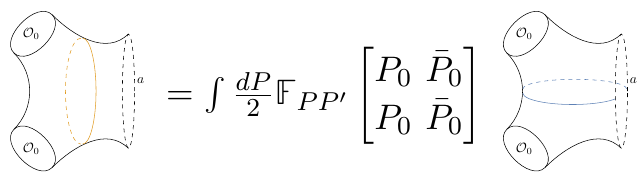
Figure 3 . The bulk OPE channel (left) and boundary OPE channel (right) of a bulk two-point function on the disk for identical bulk external operators. The corresponding conformal blocks are related with a holomorphic copy of the fusion